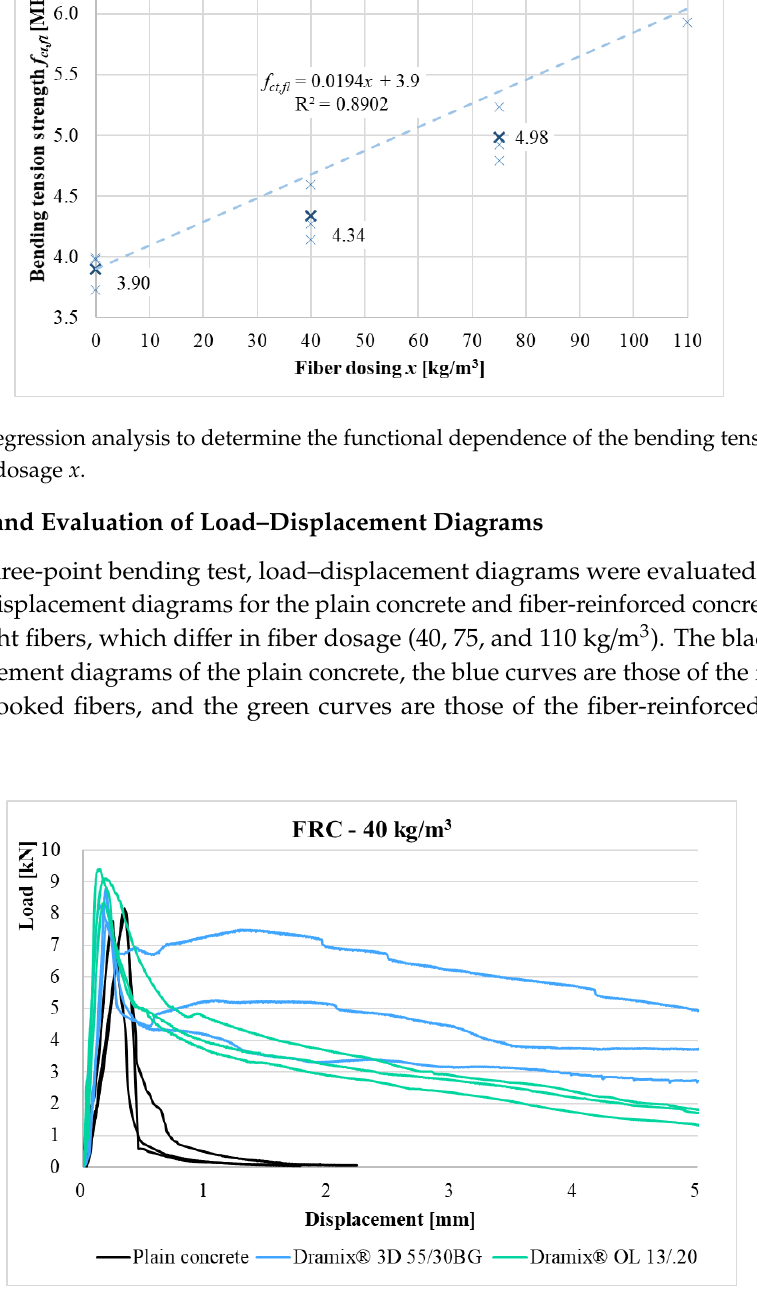
Figure 14. Load–displacement diagrams for plain concrete and fiber-reinforced concrete with a fiber dosage of 75 kg/m 3 . Figure 15 shows load–displacement diagrams for the fiber-reinforced concrete with a fiber dosage of 110 kg/m 3 and plain concrete. The most significant difference can again be observed from the curves for the fiber-reinforced concrete with hooked fibers. The first peak, where the crack is located, is not very pronounced. There is a transition to the second peak without the presence of tensile softening. This course of the curve is also typical of high-strength concrete with straight fibers, which are added to the concrete to reduce shrinkage cracks.